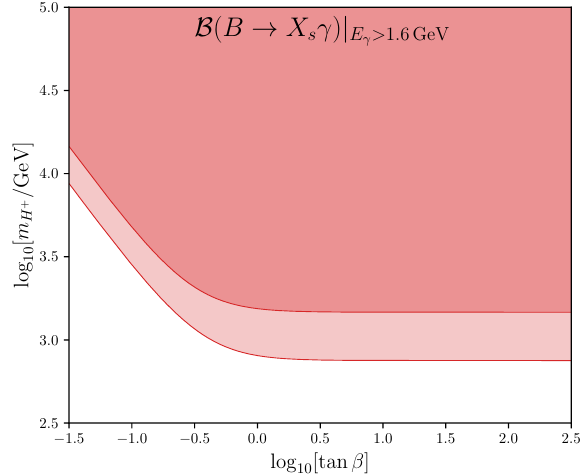
Figure 11. Contour plot of the allowed 2HDM-II parameter space in the (tan β − m for the radiative decay B → X s γ . The lighter contour indicates the allowed parameter space at 2 σ confidence level while the darker contour corresponds to 1 σ .